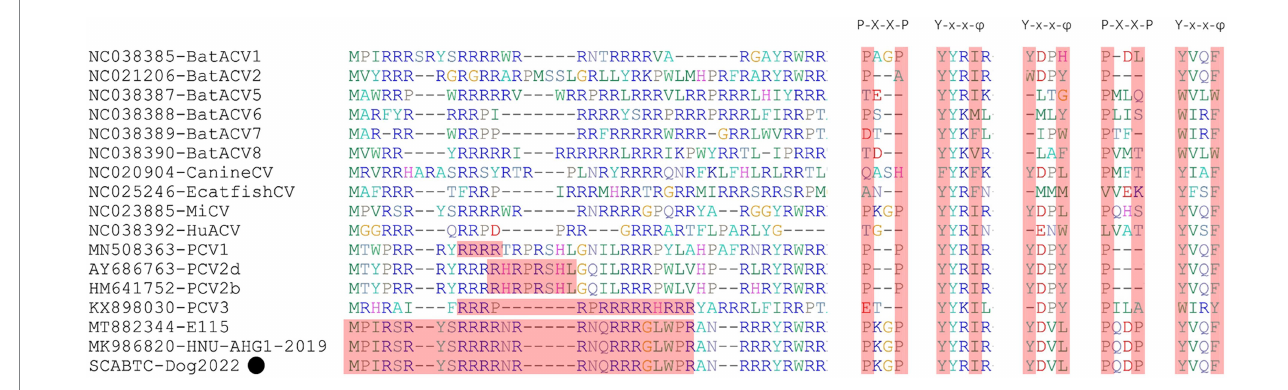
FIGURE 5 The NLS regions of PCVs (PCV1-4) were highlights in red and reported in several studies (Liu et al., 2001; Shuai et al., 2008; Mou et al., 2019; Wang et al., 2021). The P-x-x-P and Y-x-x- φ patterns were first identified in other viruses belonging to the genus Circovirus. However, the second P-x-x-P was only detected in PCV4 strains (Nguyen et al., 2022). The “x” indicates any amino acid, and “ φ ” represents any of F (phenylalanine), I (isoleucine), L (leucine), or V (valine). The black solid circle ( ● ) represented the dog-derived PCV4 strain (SCABTC-Dog2022) in this